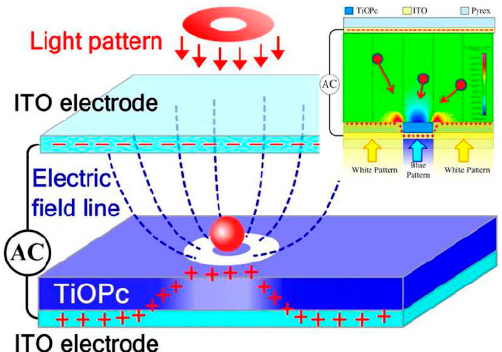
Figure 3. Structure of T i OP c -based OEK chip and simulation of the electric field (reproduced from Ref. [50]).